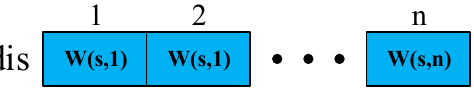
Figure 9. The representation of dis .